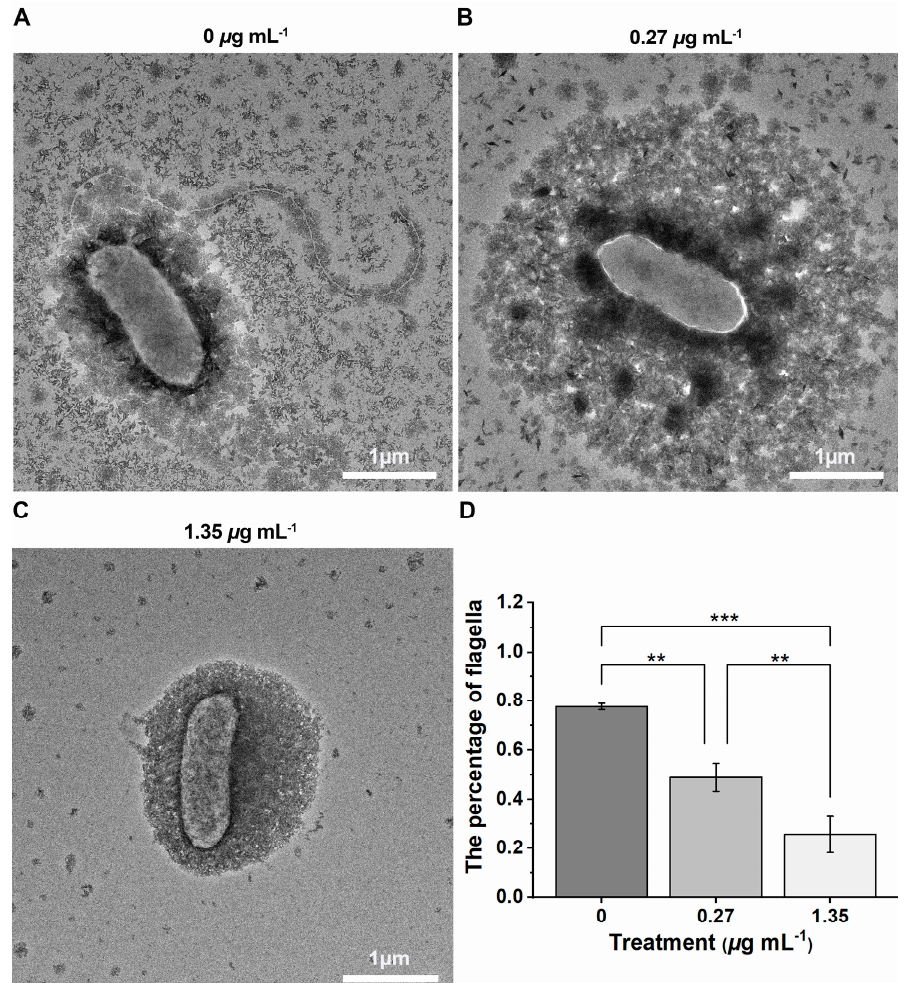
Figure 7. The Xanthomonas oryzae pv. oryzae -flagella assembly interfered with compound 2b at doses 0 (A), 0.27 (B), and 1.35 μ g mL − 1 (C), presented in the transmission electron microscope, and the percentage of flagella was showed in (D) [(**) p < 0.01, (***) p < 0.001 vs. 0]. Scale bar = 1 μ m.